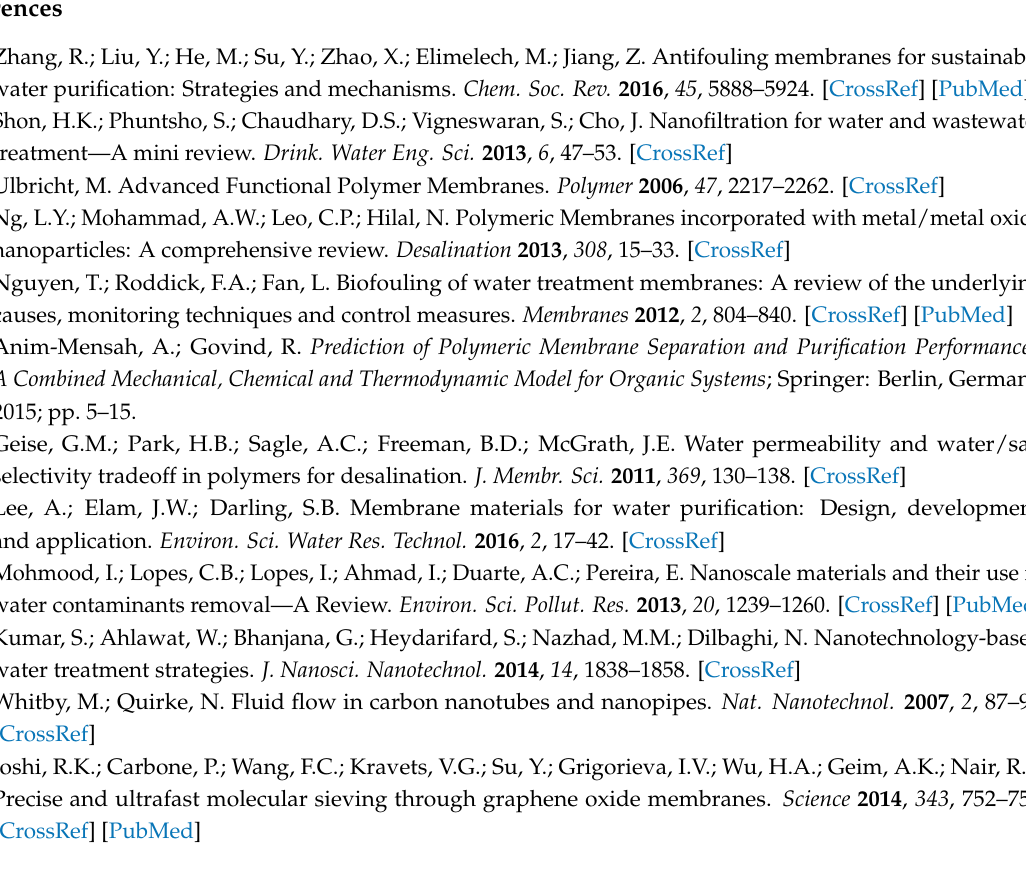
Figure S1: TGA profiles of UiO-66 nanoparticles, Figure S2: N 2 adsorption/desorption results for UiO1 and UiO5 nanoparticles: (a) isotherms; (b) micropore size distribution, Figure S3: Performance of the UiO1 composite membrane in an elongated filtration, Figure S4: cross-sectional SEM images of the UiO5 composite membranes at different loadings: (a) 1.0 mg; (b) 3.0 mg; (c) 4.0